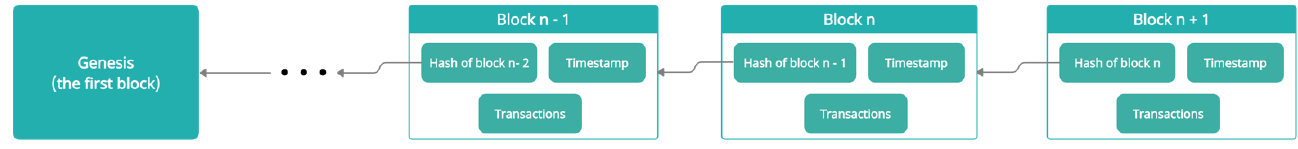
Figure 1. Blockchain data structure, adapted from [16–18].